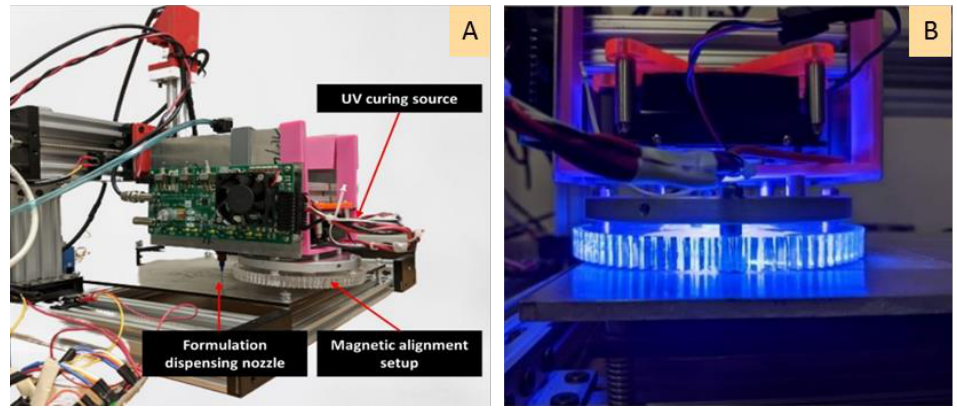
Figure 5. ( A ) Material jetting equipment with the in-situ particle alignment system and ( B ) UV source irradiating polymer sample for curing.